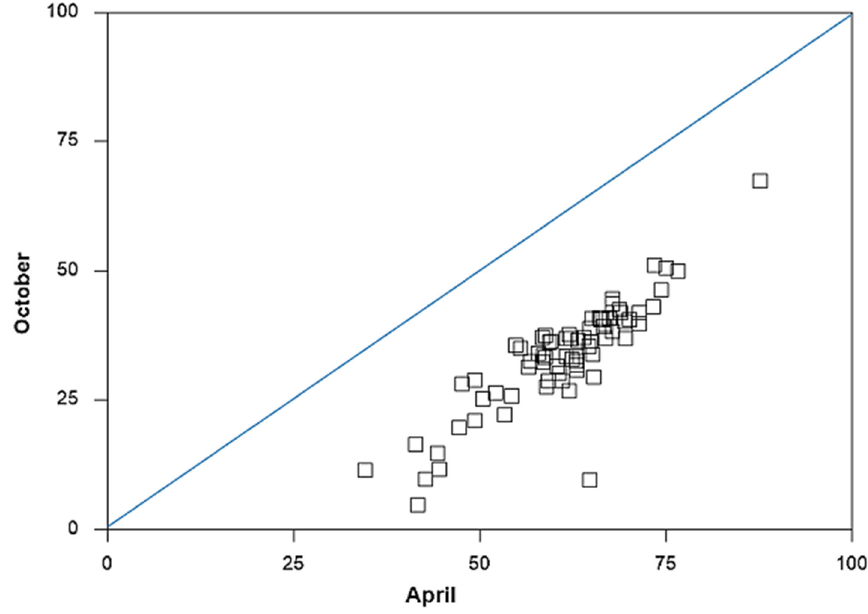
Figure 2. Percentage of unvaccinated population by census tract, age 12 and older. Despite the observed spatial patterns across census tracts, the challenge of getting eligible individuals vaccinated seemed to prevail over time. To understand this, we compare the vaccination rates in October with those in April. Across the county, 28% more residents became fully vaccinated between May and October. Figure 3 displays a scatter plot of the full vaccination rates for census tracts between April and October. Clearly, the vaccination rate increased in tandem across most census tracts. This means little catchup over time from census tracts with relatively fewer vaccinations.